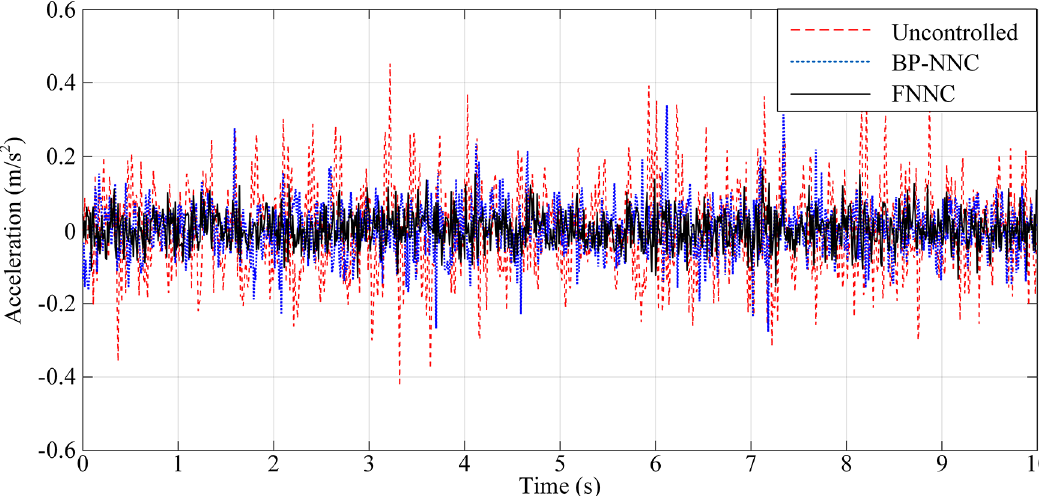
Fig. 27. Time-domain response of horizontal vibration acceleration of the elevator car frame with a full load.